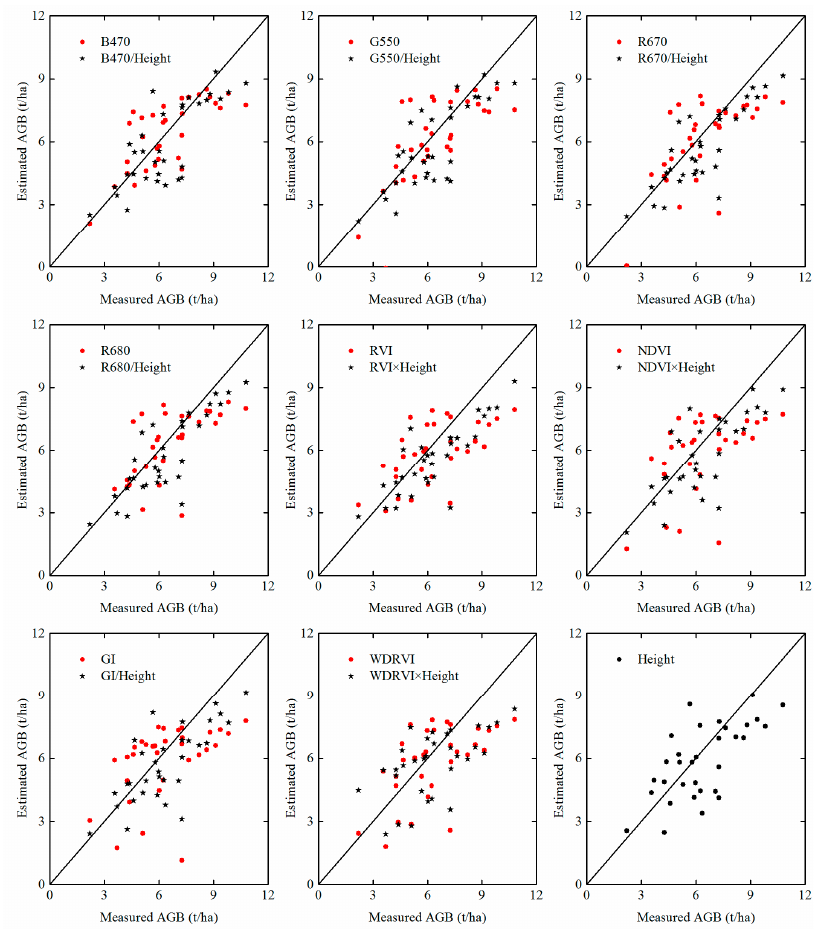
Figure 8. Comparison of measured and improved model estimated AGB.